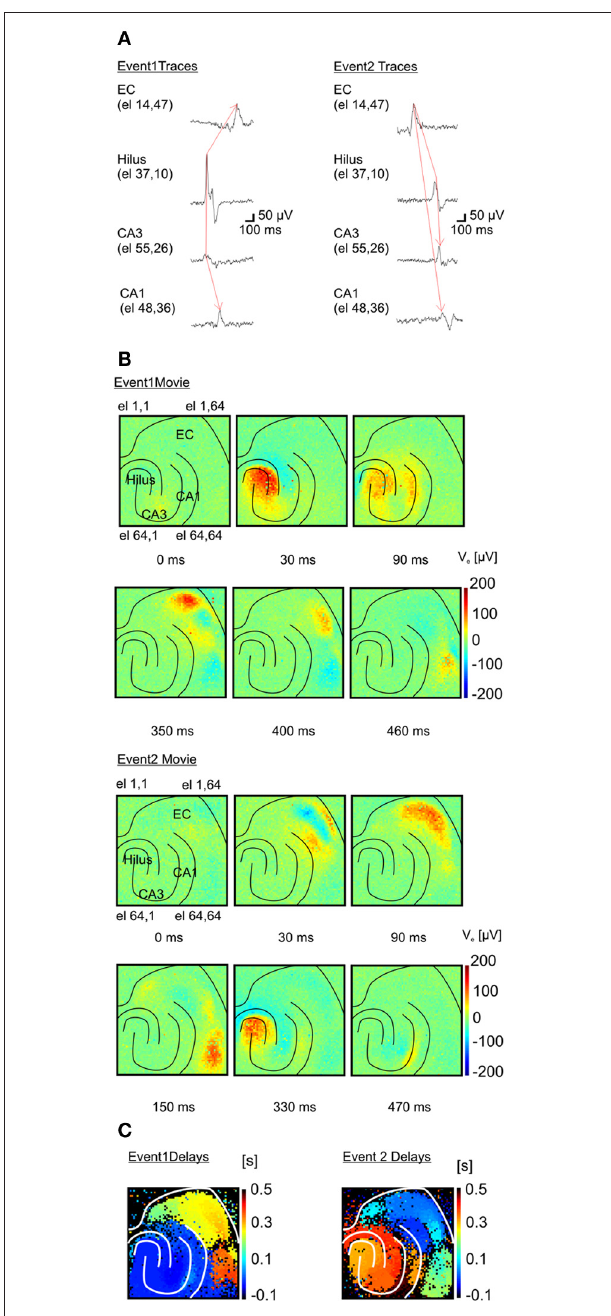
FIGURE 6 | Functional imaging of an I-IC event propagation. (A) Two distinct inter-ictal (I-IC) events are represented. Temporal traces corresponding to four different electrodes for each event in different regions: entorhinal cortex (EC), hilus, CA3 and CA1 in the hippocampus. For both events, the red arrow indicates the direction of propagation: event 1 is generated in CA3, propagates to the hilus and afterwards to the EC, whereas event 2 is generated in the EC and propagates to the hilus, CA3 and CA1. (B) Time-lapse color-coded voltage maps of extracellular voltages illustrating in detail the different dynamics of propagation for both events. (C) Maps of the propagation delays computed for each event with respect to a reference pixel in the region of origin of each event. These maps clearly evidence the two distinct